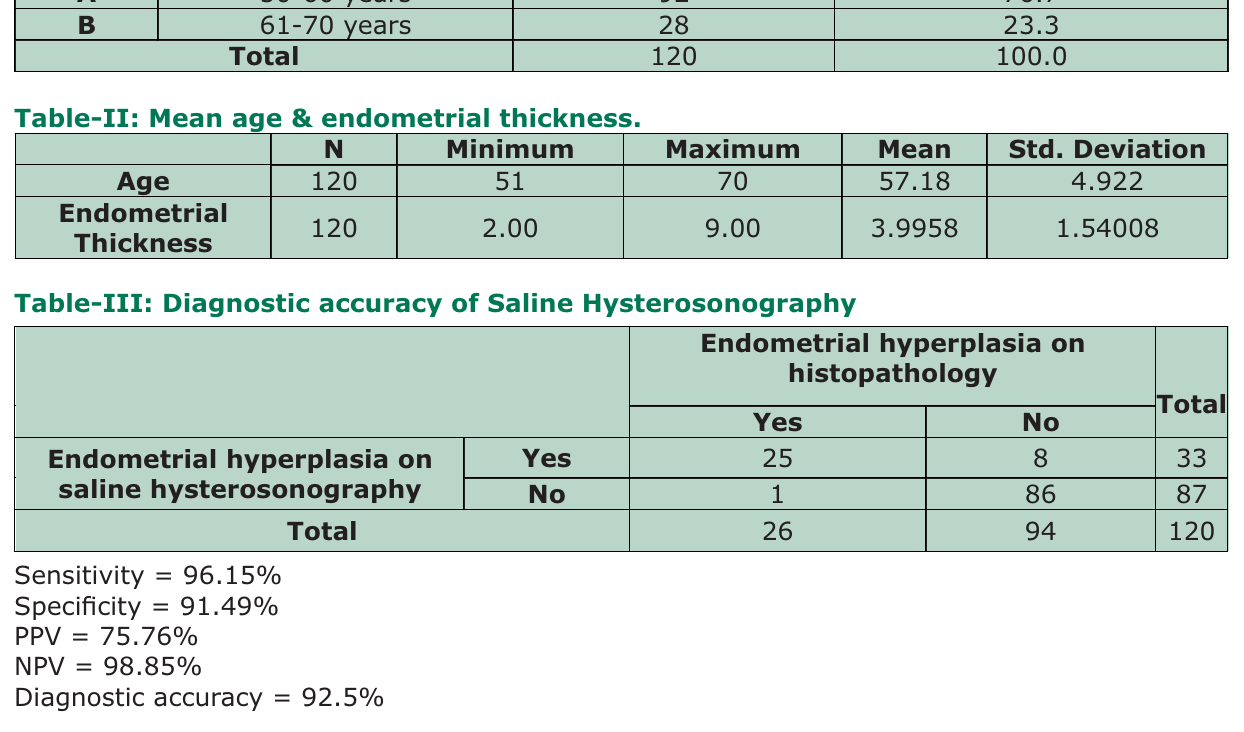
Table-IV: Diagnostic accuracy of saline hysterosonography in different age groups.